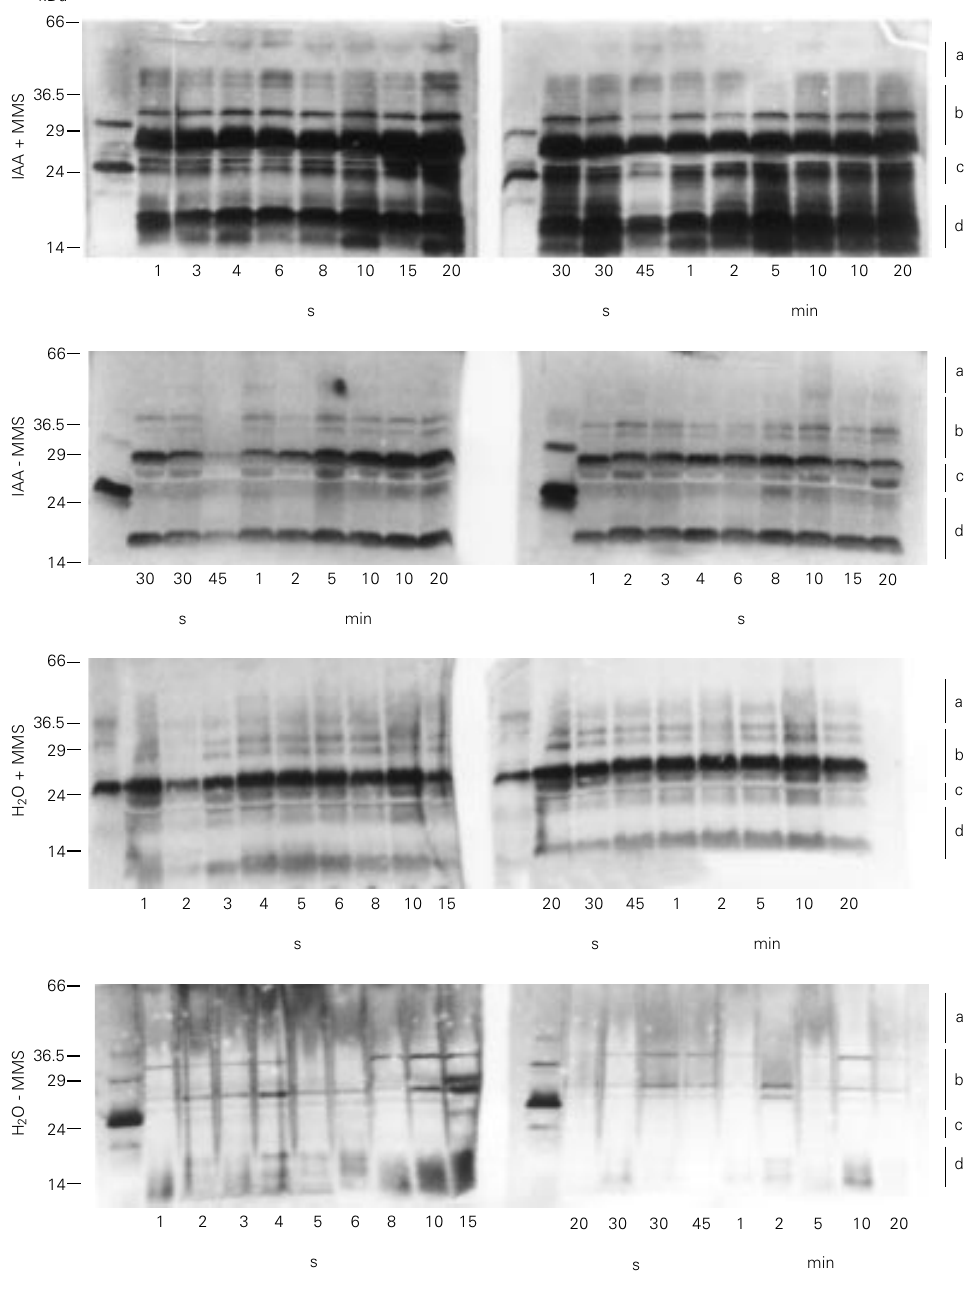
Figure 1 - SDS-PAGE of latex fractions from Carica papaya .